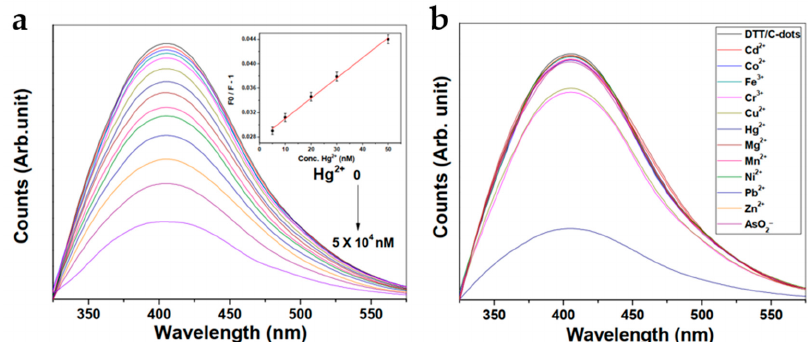
Figure 22. ( a ) Fluorescence quenching by Hg 2 + ions at various concentrations, with inset Stern–Volmer plot used to determine detection limit; ( b ) fluorescence quenching capacity of a range of ions, showing strong selectivity for Hg 2 + . Reproduced from reference [85] with permission from The Royal Society of Chemistry.